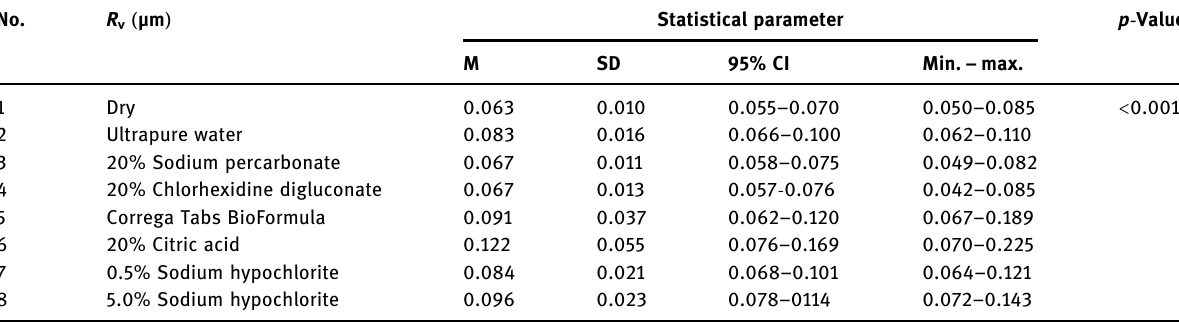
Table 5: Descriptive statistics for R v measurements outcome